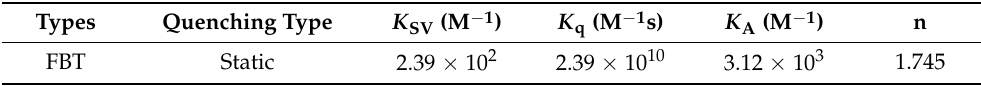
Table 2. The fluorescence parameters between FBT and